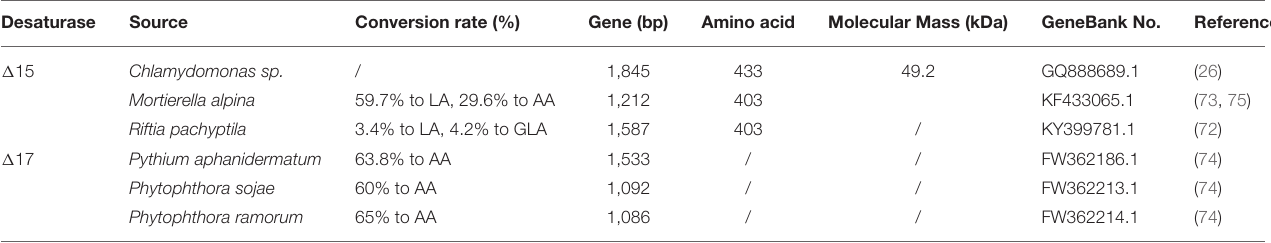
TABLE 3 | The characteristic of the ω